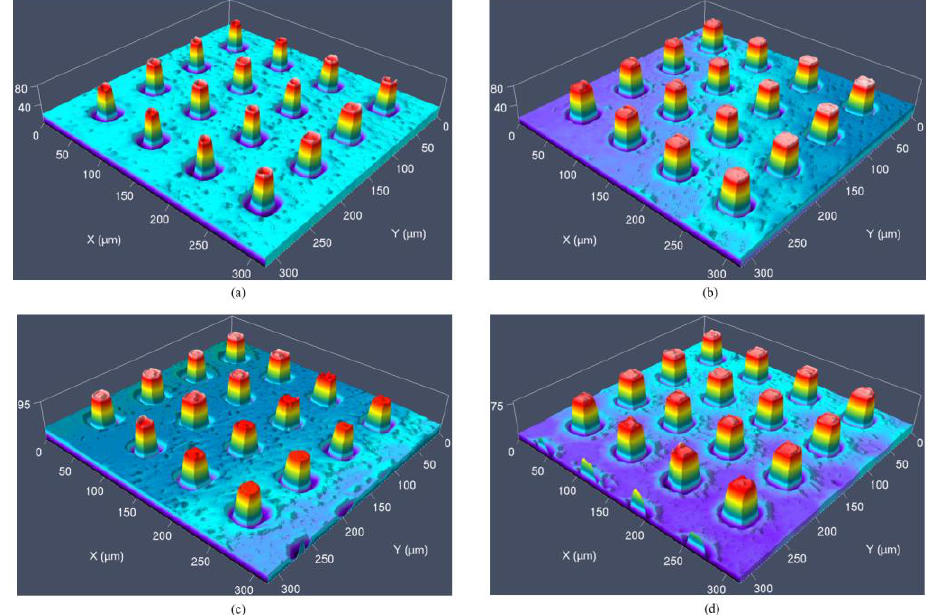
Figure 9. Three-dimensional topography after first demolding of ( a ) no coating; ( b ) DT; ( c ) DDT; ( d ) PFDT .